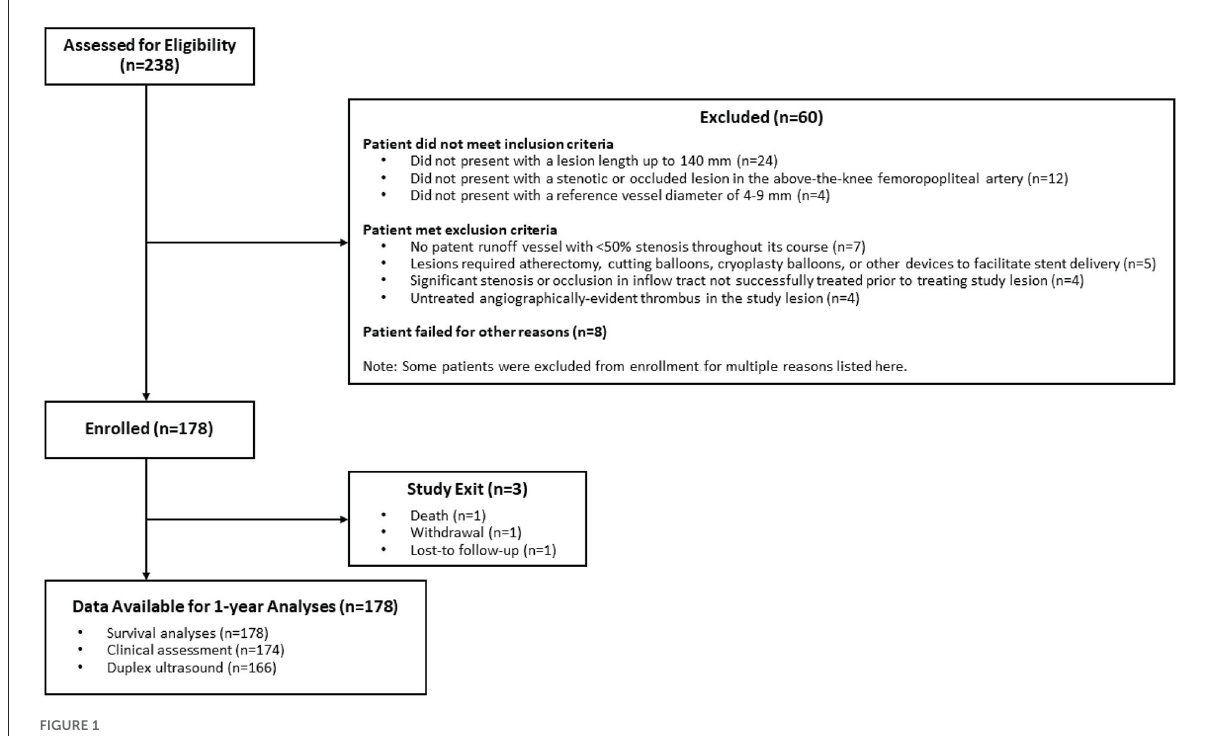
FIGURE1 Patient flow